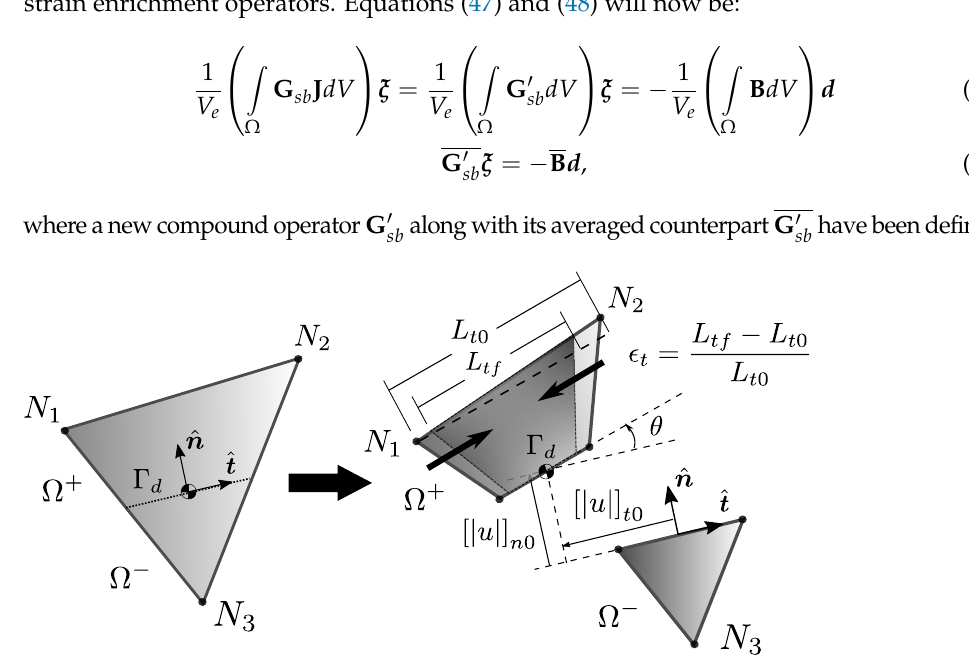
] ] u u , [ , one rigid body rotation θ and a single n 0 t 0 | | | |